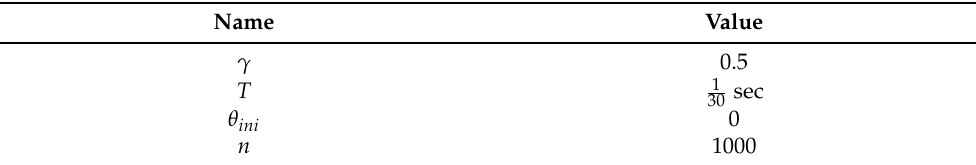
Table 3. Experimental parameters.